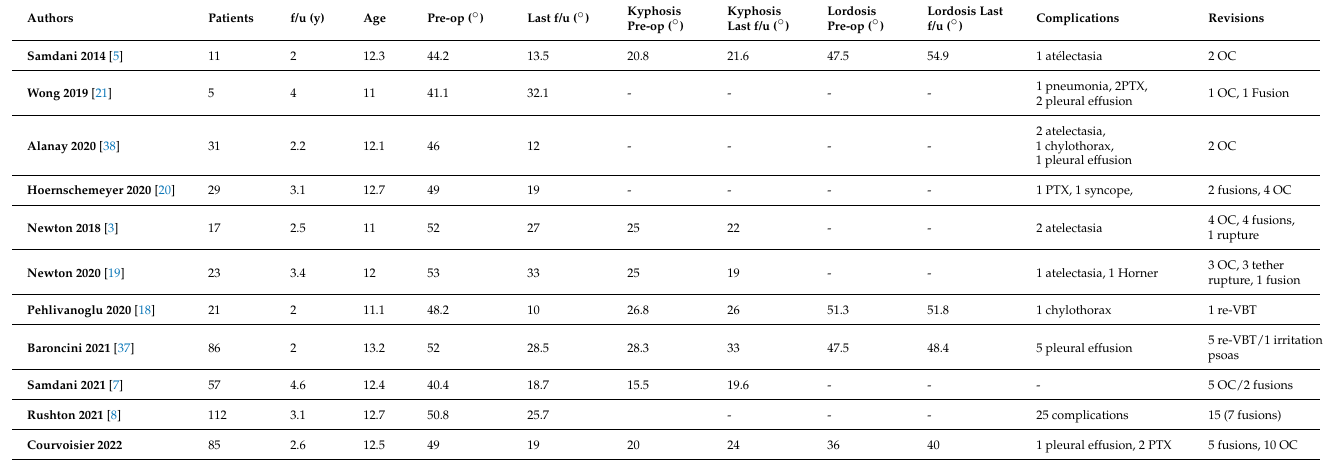
Figure 6. Same patient as Figure 6. Lateral radiographs evolution over the same period of 2.5 years.